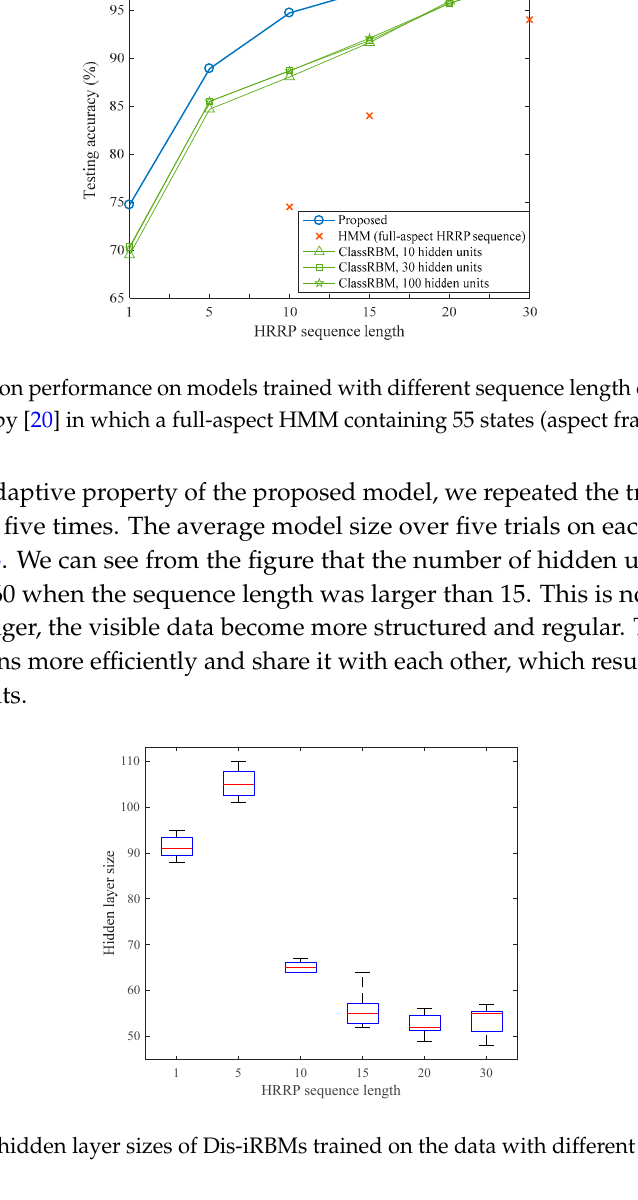
Figure 5. Effective hidden layer sizes of Dis-iRBMs trained on the data with different sequence lengths.